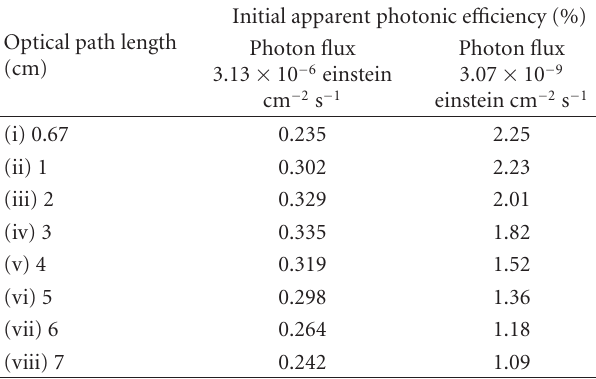
Table 2: Relative photonic e ffi ciencies of photocatalytic degrada- tion of MB with di ff erent optical path length and TiO 2 concentra-